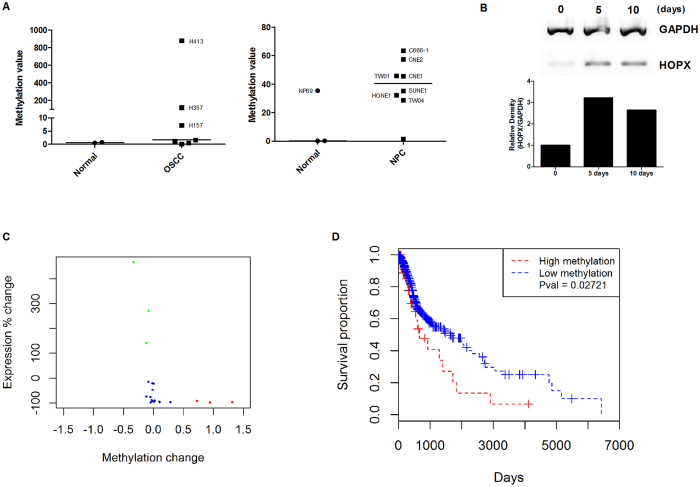
HOPX promoter methylation in HNSCC.Quantitative analysis of HOPX-β promoter methylation in OSCC and NPC cell lines with normal oral keratinocytes and immortalised nasopharyngeal epithelial cell lines (A). Treatment of H413 OSCC cells with the demethylating drug, zebularine, for 5–10 days induced re-expression of HOPX (B). HOPX-β promoter methylation was associated with a reduction of HOPX expression as determined by comparing expression in matched tumour and normal data within the TCGA HNSCC dataset (C). Hypermethylated cases are shown in red, those with higher expression than their matched normal are shown in green, with the remainder shown in blue. Kaplan Meier survival analysis showed there was a significant association between HOPX-β promoter methylation and worse overall survival (D).